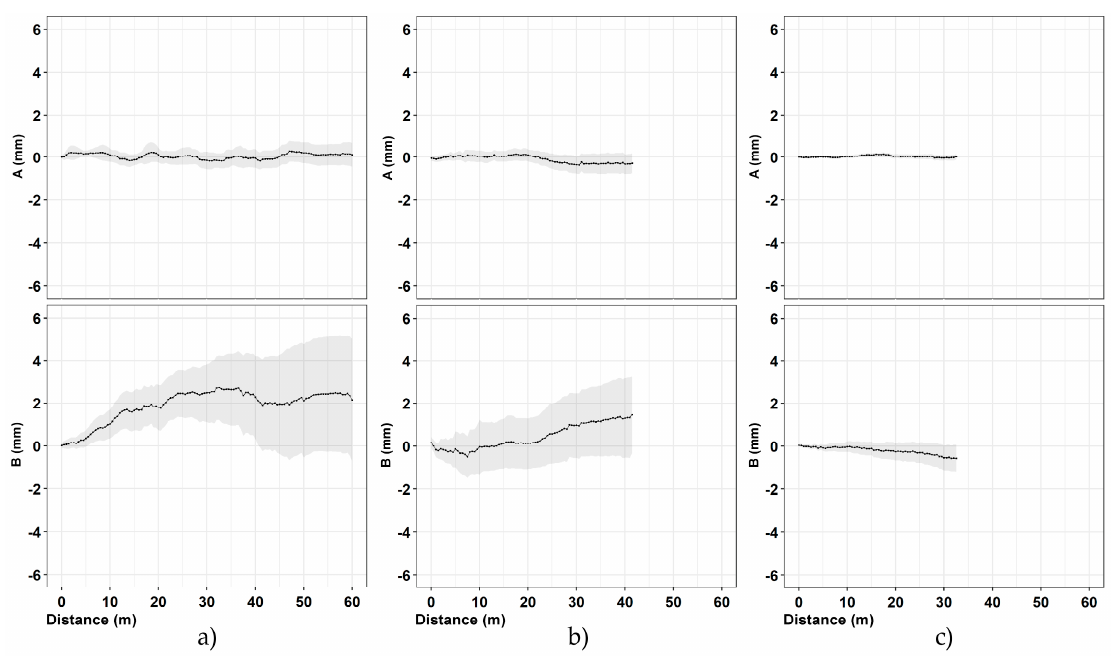
Figure 15. Cumulative displacements for each channel (upper frame channel A, lower frame channel B) in relation to distance from the toe of the borehole: ( a ) Section 1—62.5 tube length; ( b ) Section 2—42.5 tube length; and ( c ) Section 3—33.5 tube length. The grey area shows the error interval